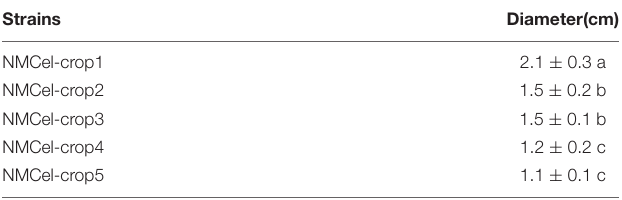
TABLE 2 | Diameter of hydrolytic ring of the selected five strains.